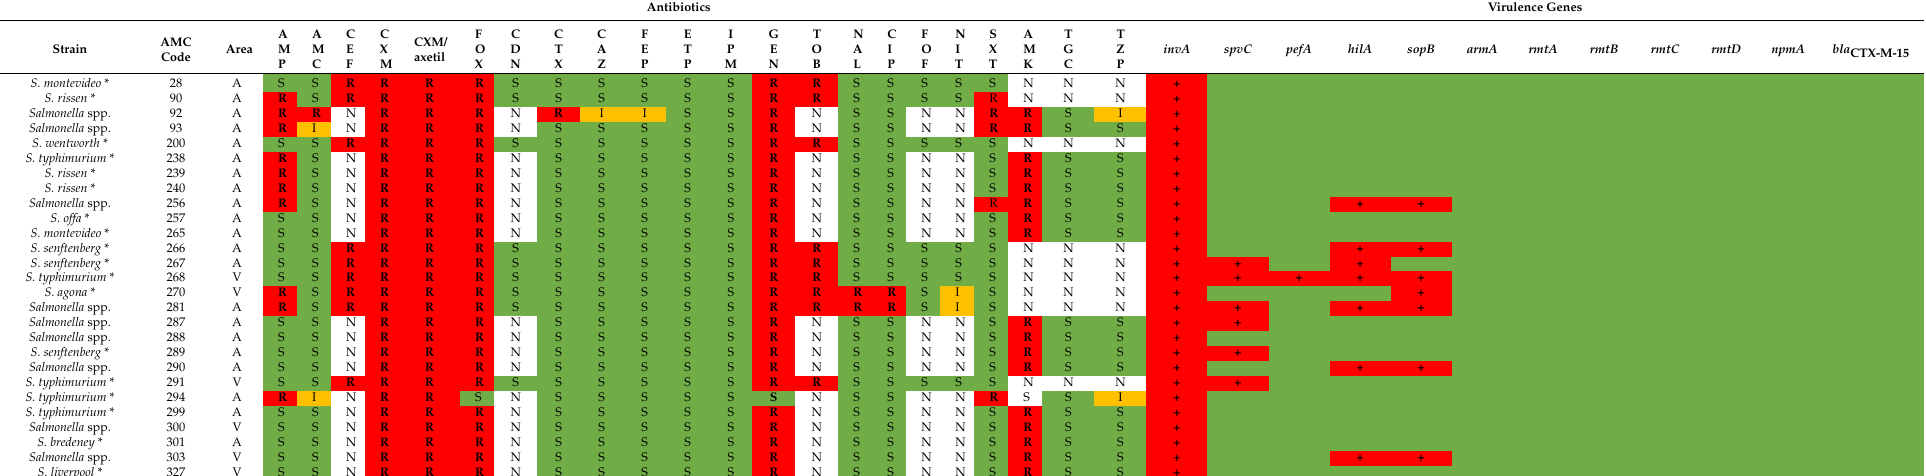
Table 4. Summary of the antibiotic resistance and virulence genes for each of the strains isolated.